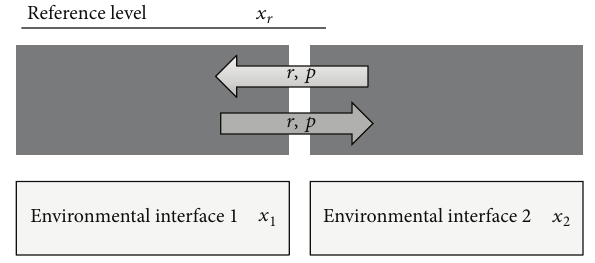
Figure 3: Schematic diagram of horizontal energy exchange between two environmental interfaces. Parameters 𝑝 and 𝑟 express intrinsic property of the environmental interfaces and the influence of the environment,